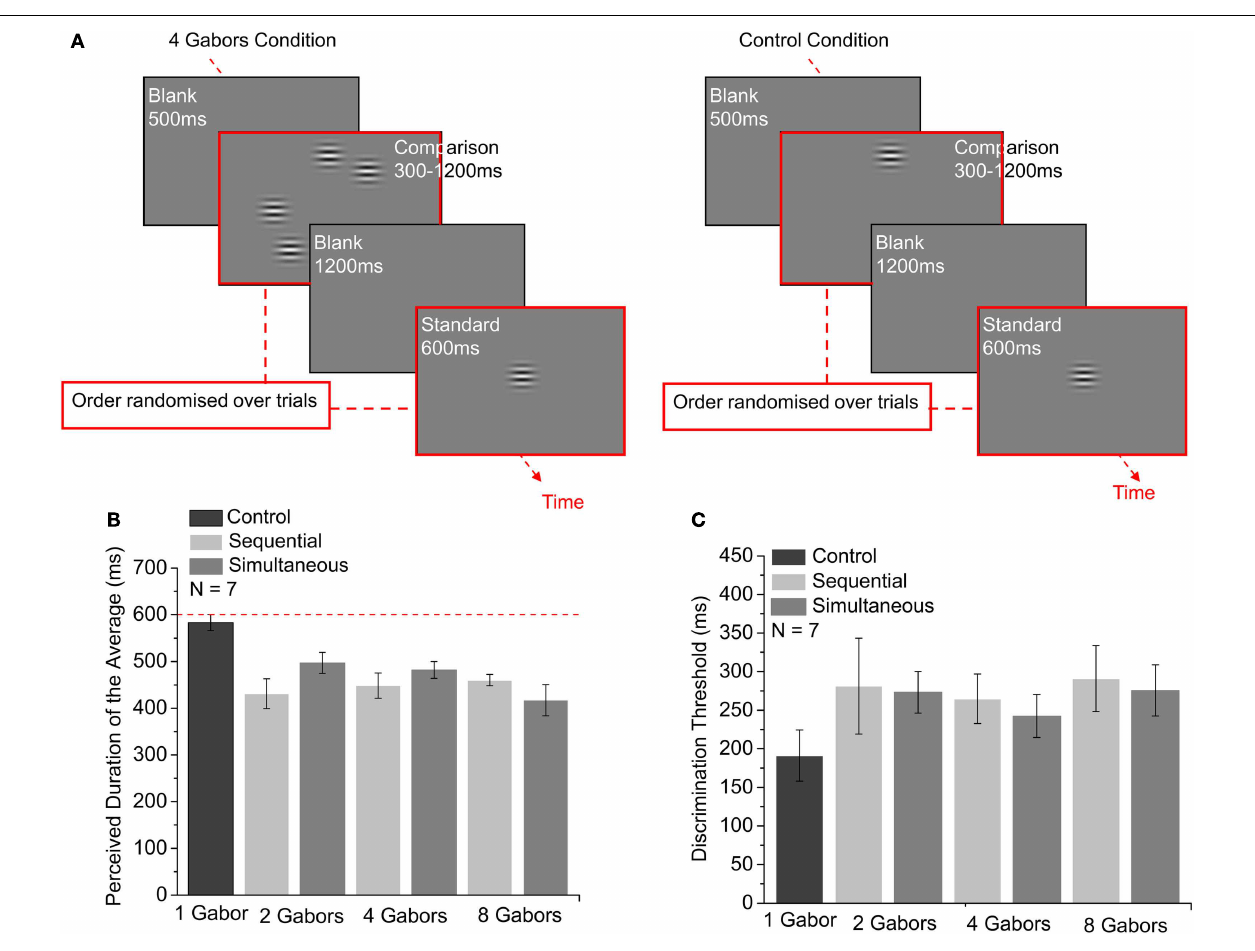
standard presented centrally. (B) Mean perceived durations of the average are plotted as a function of the number of Gabor stimuli on the comparison array.The dashed line indicates the duration of the standard Gabor. Error bars show ± 1 SE of the mean. Each point is derived from 140 trials. (C) Duration discrimination thresholds are plotted in the conditions shown in (B) . Error bars show ± 1 SE of the mean. Each point is derived from 140